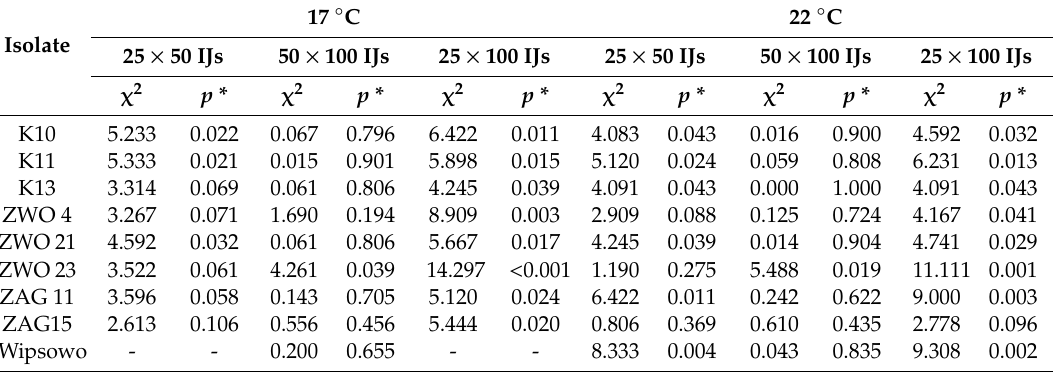
Table 4. The e ff ect of EPN dosages applied at two temperatures on the mortality of the cabbage moth parasitism